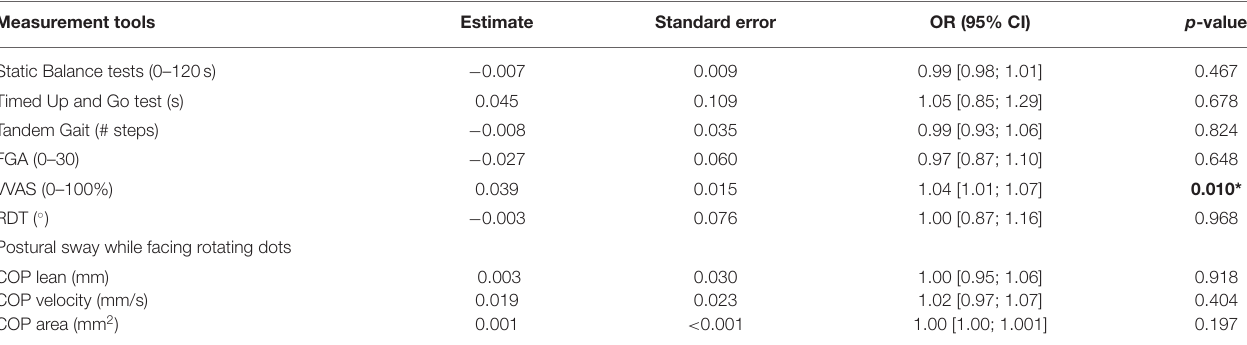
TABLE 5 | Univariable logistic regression of the clinical tests for the prediction of PPPD in patients with chronic dizziness a,b . Measurement